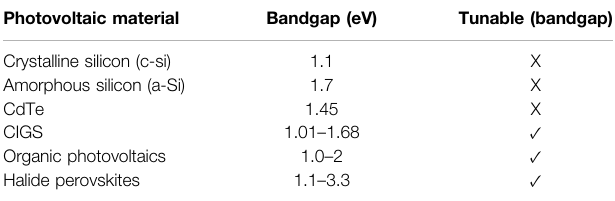
TABLE 1 | Different photovoltaic materials and their